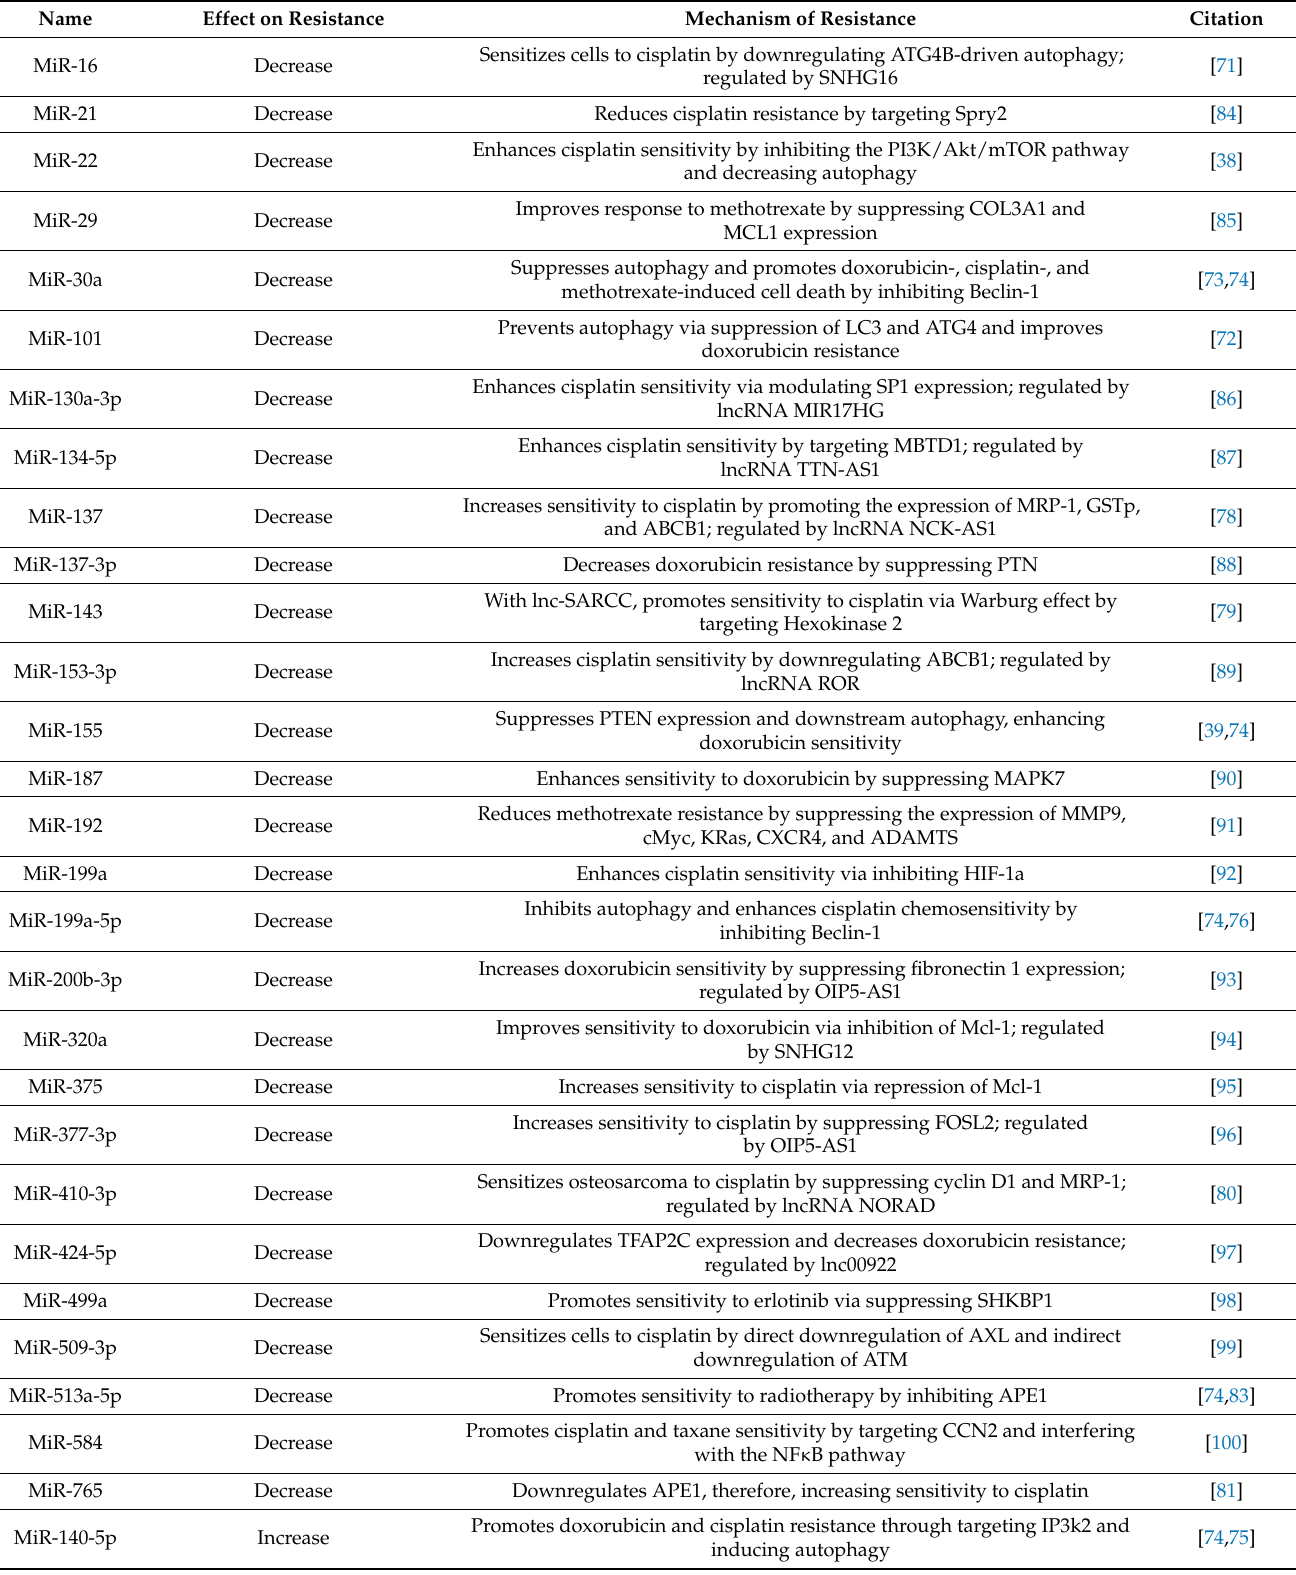
Table 1. MiRNA that are implicated in osteosarcoma therapy